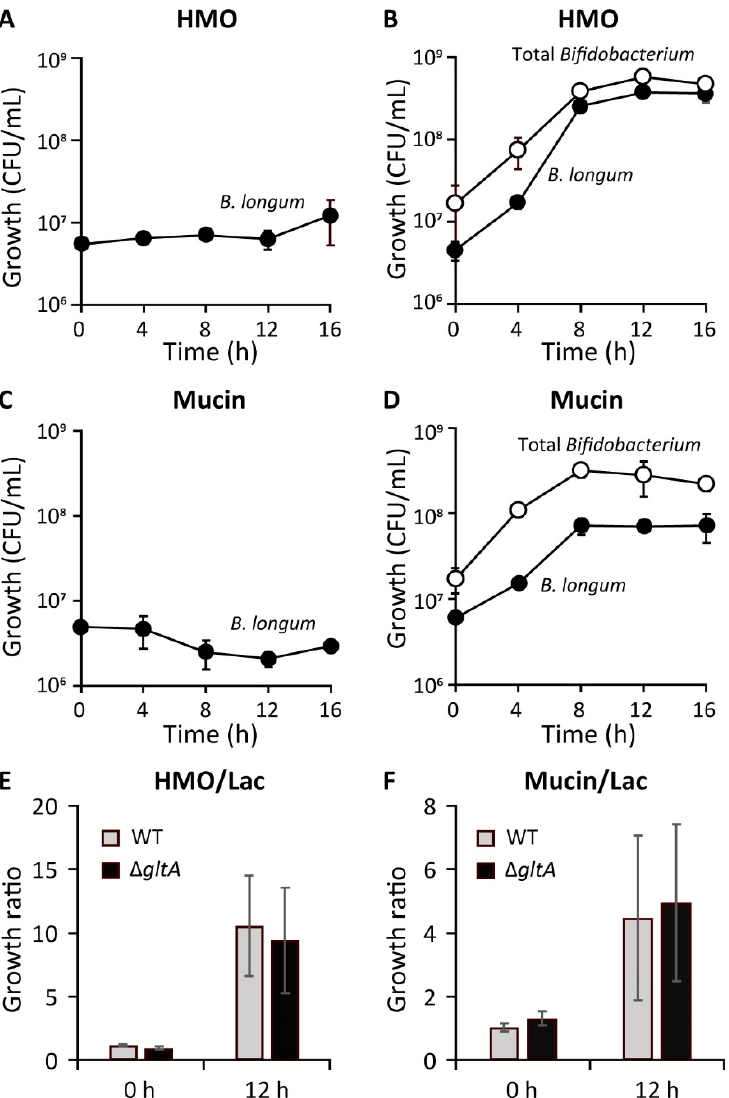
Figure 4. B. bifidum -mediated cross-feeding supports the growth of B. longum on HMO- and mucin-containing media. ( A – D ): The growth of B. longum 105-A in a basal medium supplemented with 1% human milk oligosaccharides (HMOs) ( A , B ) or 1% porcine gastric mucin ( C , D ) in the absence ( A , C ) and presence ( B , D ) of B. bifidum JCM 1254. The wild-type B. longum 105-A strain carrying the chloramphenicol ( A , B ) or spectinomycin ( C – F ) resistance gene on a plasmid (pBFS38 or pBFO2, respectively) [97] was used for monitoring the growth. Colony-forming units (CFU) of B. longum 105-A were determined by spreading the serial dilution of the cultures on the agar plates containing the antibiotics (closed circles), while the CFU of total Bifidobacterium was determined using the agar plates without antibiotics (open circles). The data used in ( A ) was obtained from our previous study [28]. ( E , F ): The growth competition between wild-type and ∆ gltA mutant strains of B. longum 105-A in the presence of B. bifidum JCM 1254. Lactose (Lac), HMOs, or PGM was used as the sole carbon source. The ratio of the growth on HMOs ( E ) or PGM ( F ) that was normalized by that on Lac was compared. The ∆ gltA mutant was transformed with pBFS38 [97] carrying the chloramphenicol resistance gene, and CFU was determined on agar plates containing the antibiotics.